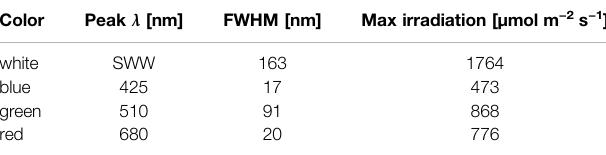
TABLE 2 | Light-emitting diode (LED) properties of the installed LED in each illuminationbase.SWWisastandardwarmwhiteLED.Peak λ ,fullwidthathalf maximum (FWHM) and max irradiation determined via